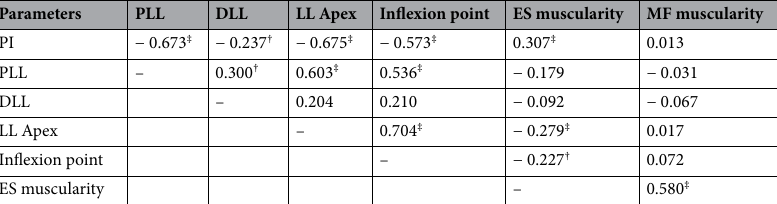
Table 2. Pearson correlation analysis of lumbar morphology, pelvic incidence and paraspinal muscles. PI pelvic incidence, PLL proximal lumbar lordosis, DLL distal lumbar lordosis, LL Apex lumbar lordosis apex, ES